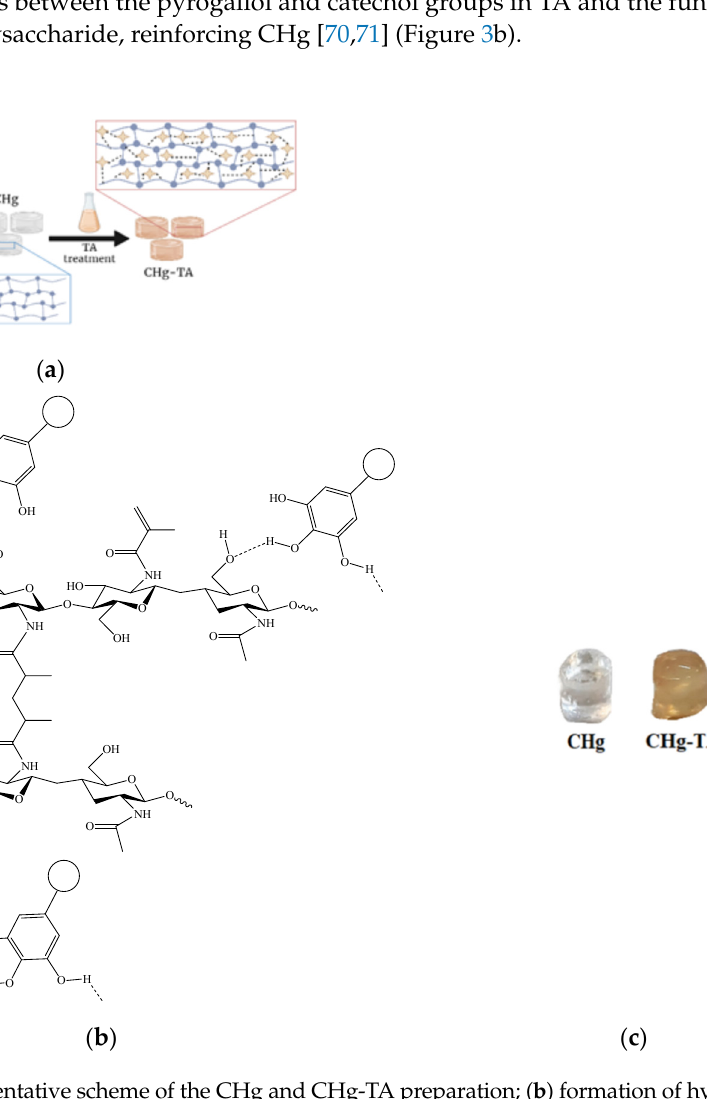
( b ) Figure 4. SEM images on a representative macro area (100× g mag.) of ( a ) CHg and ( b ) CHg-TA.